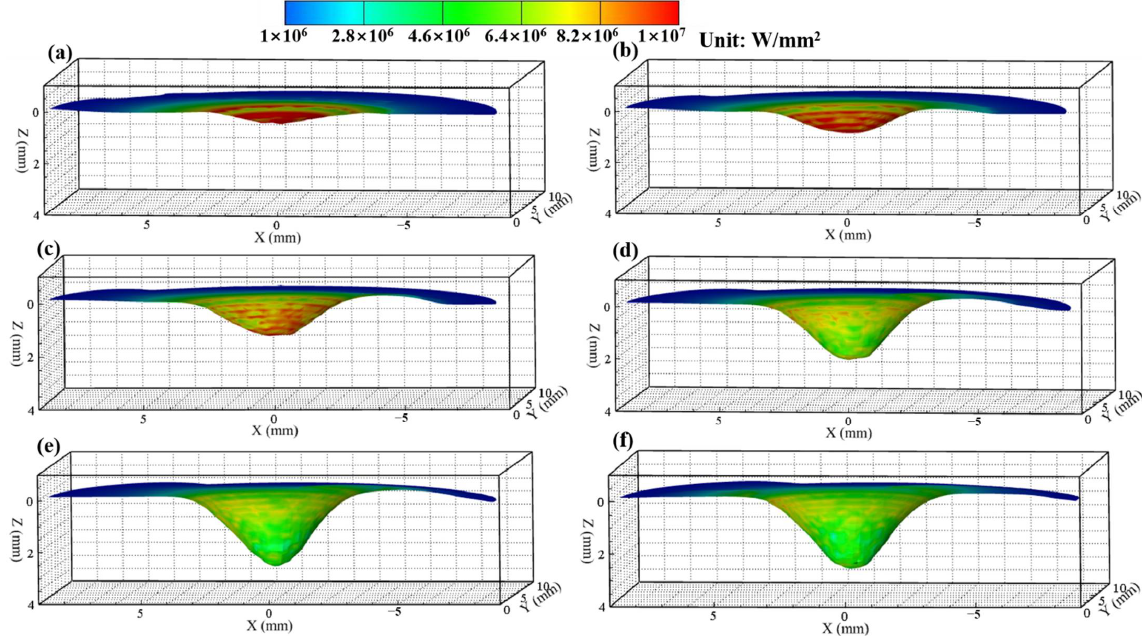
Figure 7. The dynamic keyhole evolution process in PAW ( a ) 1.21, ( b ) 2.02, ( c ) 2.5, ( d ) 3.2, ( e ) 4.01, ( f ) 4.6 s.